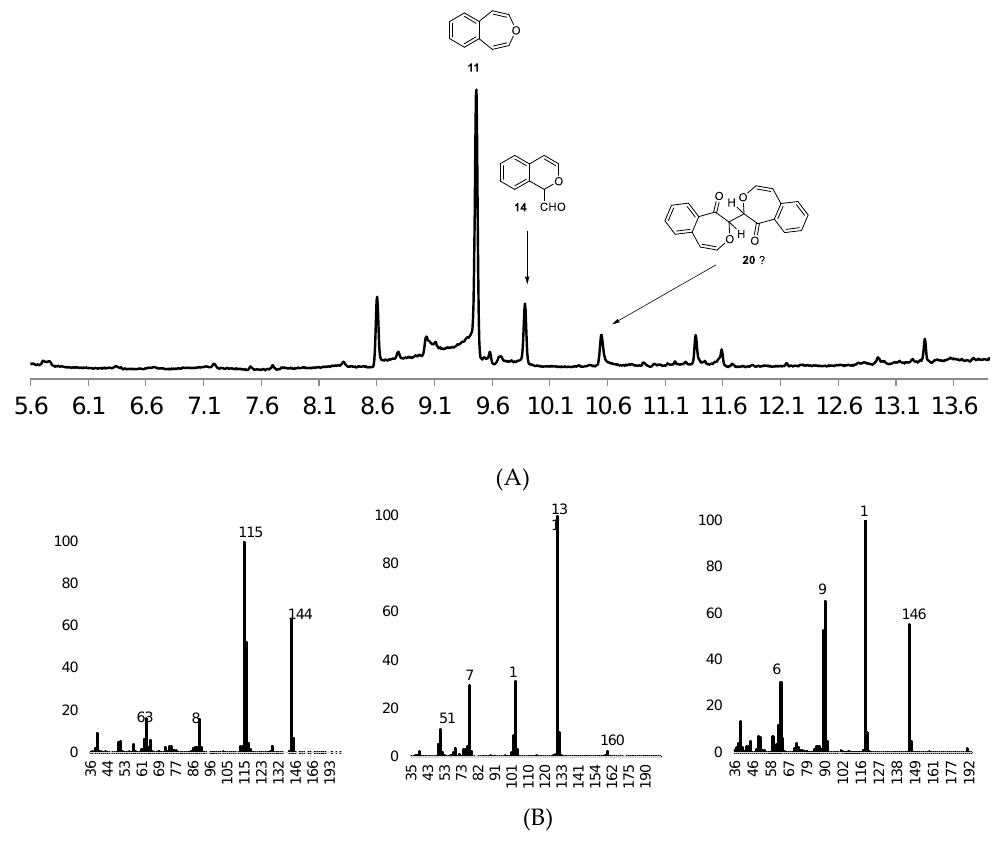
Figure 1. ( A ) Total Ion Chromatogram (TIC) for reaction of 4,5-benzoxepin 11 with P450 1A2; ( B ) mass spectra of compounds 11 , 14 , and 20 , respectively.